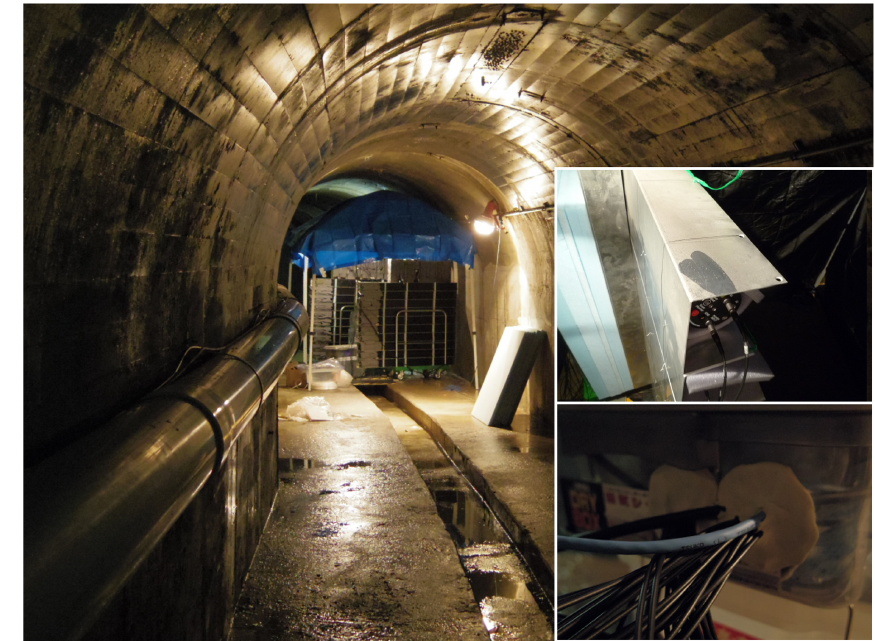
Fig. 1. Schematic of the detector design for the present measurement.